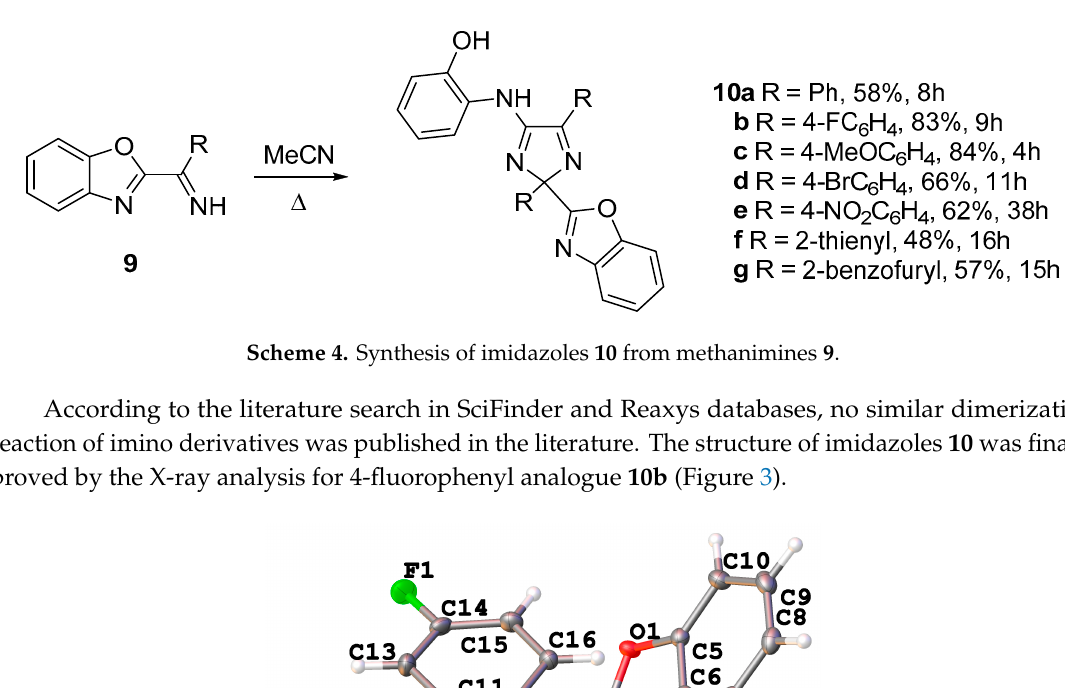
Figure 2. The molecular graphs of two isomers with trans- ( A ) and cis- ( B ) disposition of C=N bonds. The critical points (3, − 1) and (3, +1) are shown by small green and red balls. The bond path for C-H···O and C-H···N interactions are shown by dashed lines.